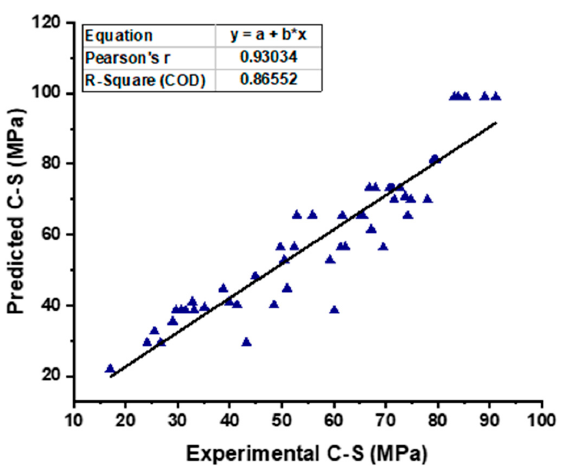
Figure 7. Experimental and predicted outcomes relationship of CS from MLP model.